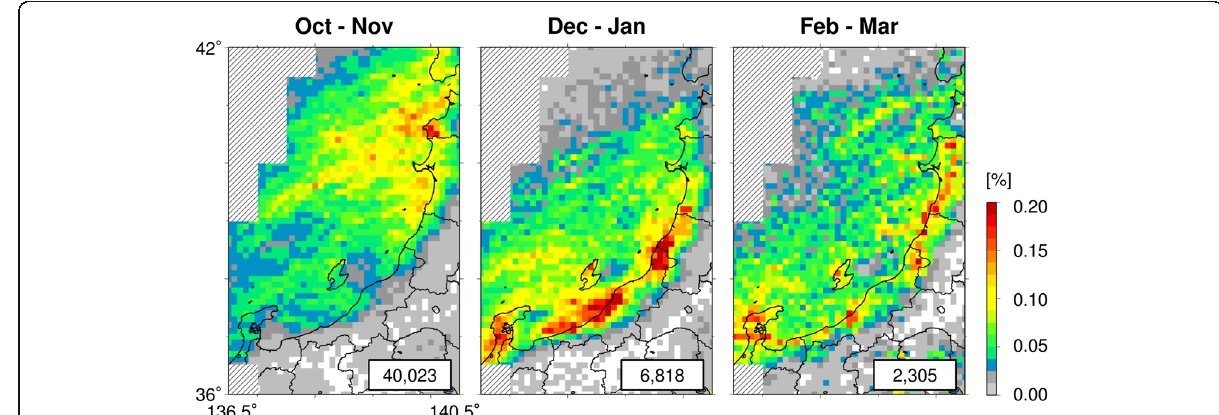
Fig. 4 Seasonal variation of lightning frequency distribution in the study